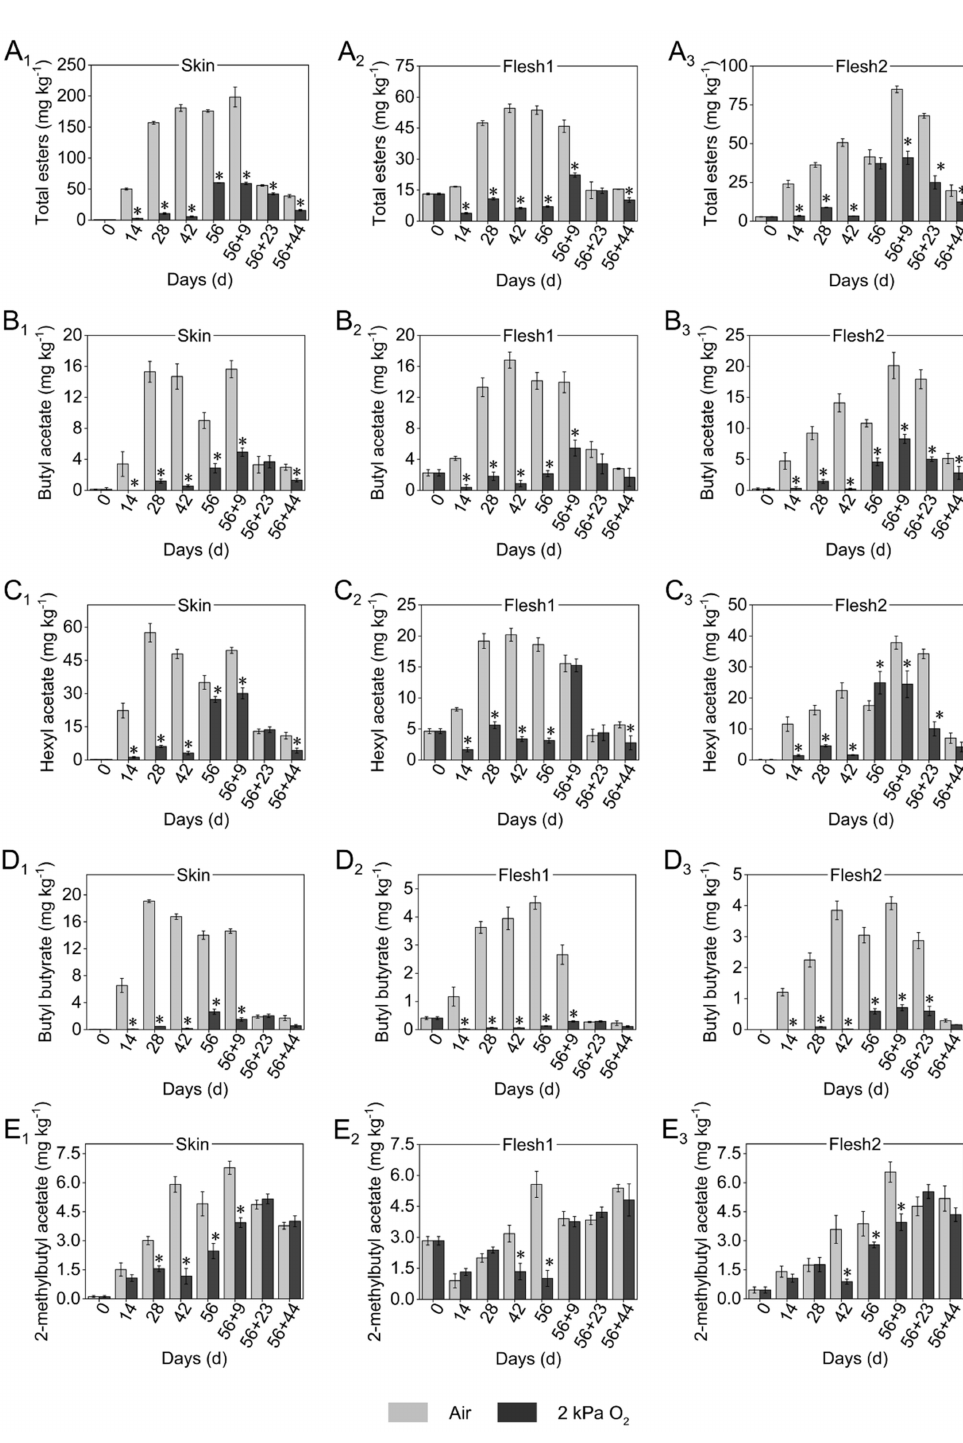
Figure 2. Key ester content in skin and flesh of ‘Golden Delicious’ apple fruit during 56-day storage under 2 kPa O 2 + 98 kPa N 2 at 4 ◦ C and subsequent 44-day shelf life at 20 ◦ C. The contents of total esters, butyl acetate, hexyl acetate, butyl butyrate and 2-methylbutyl acetate are shown in ( A 1 – A 3 , B 1 – B 3 , C 1 – C 3 , D 1 – D 3 and E 1 – E 3 ), respectively. Air represents apple fruit stored in air; 2 kPa O 2 represents fruit stored under 2 kPa O 2 + 98 kPa N 2 . Skin indicates tissue obtained 0 − 0.1 mm of top pericarp; Flesh1 and Flesh 2 indicate flesh tissues obtained, respectively, 0.1 − 1.0 cm and 2.0 − 3.0 cm below the exocarp. Bars indicate standard deviation for each mean value from at least three replicates. Asterisks indicate significant difference between air-stored and 2 kPa O 2 -stored fruit at p < 0.05 (Duncan’s multiple range